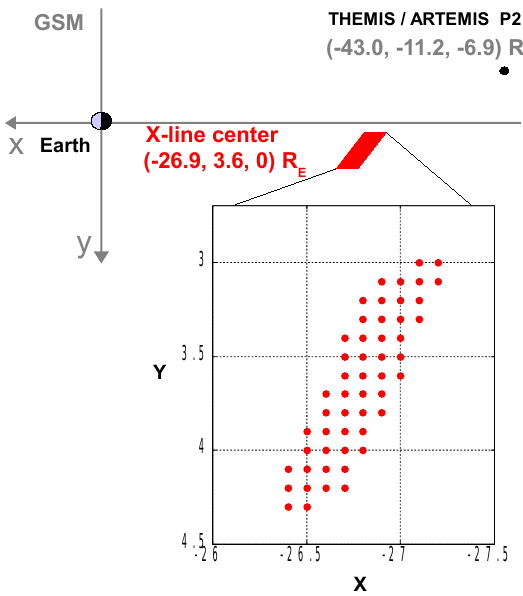
Fig. 6. X-line location obtained from numerical procedure, de- scribed in Sect. 4. Red points present the convergence area. Fig. 6. X -line location obtained from numerical procedure, described in Sec. 4. Red points present the convergence area.